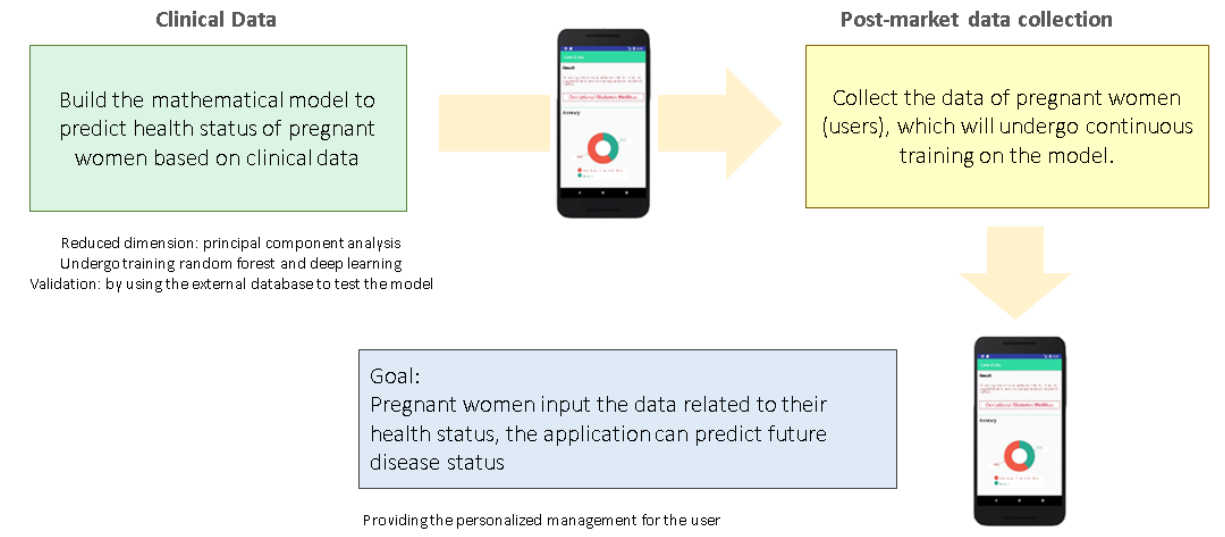
Figure 2. How the AI app